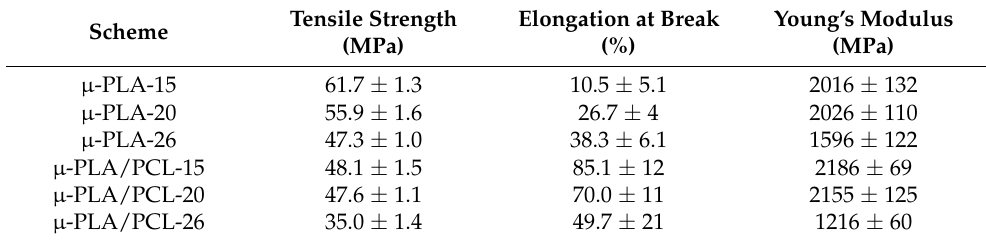
Figure 9. The stress-strain curves of microparts with different cavity size for pure PLA and PLA/PCL blends. Table 6. The tensile properties of microparts with different cavity size for pure PLA and PLA/PCL blends.